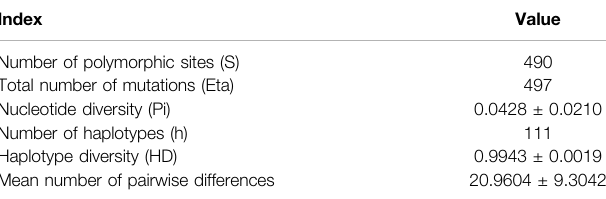
TABLE 1 | Genetic diversity indexes of the Daur ethnic group.